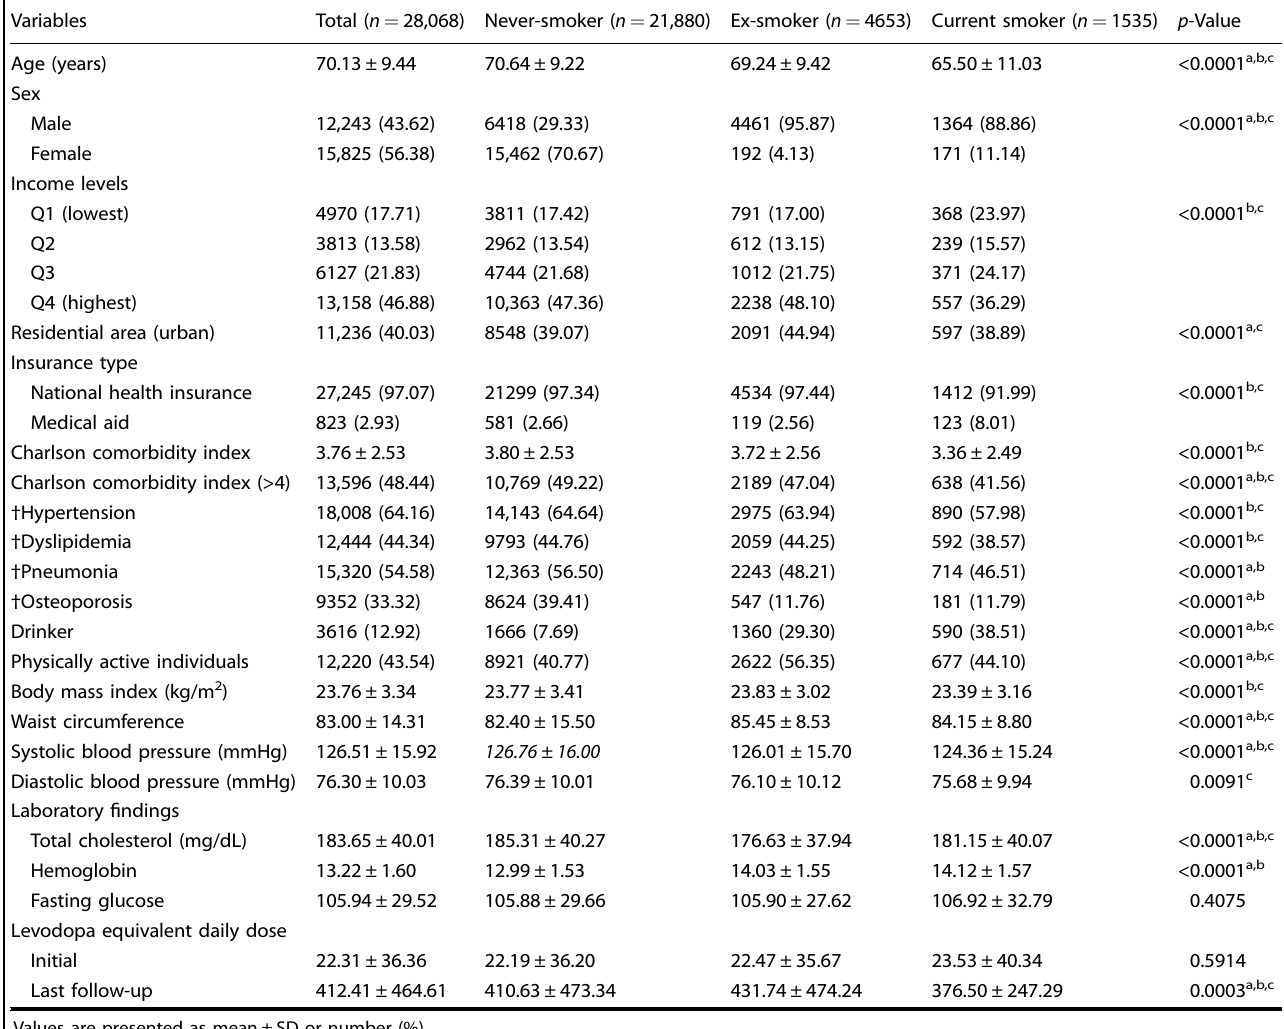
Table 1. Demographic and medical characteristics of individuals with Parkinson ’ s disease.